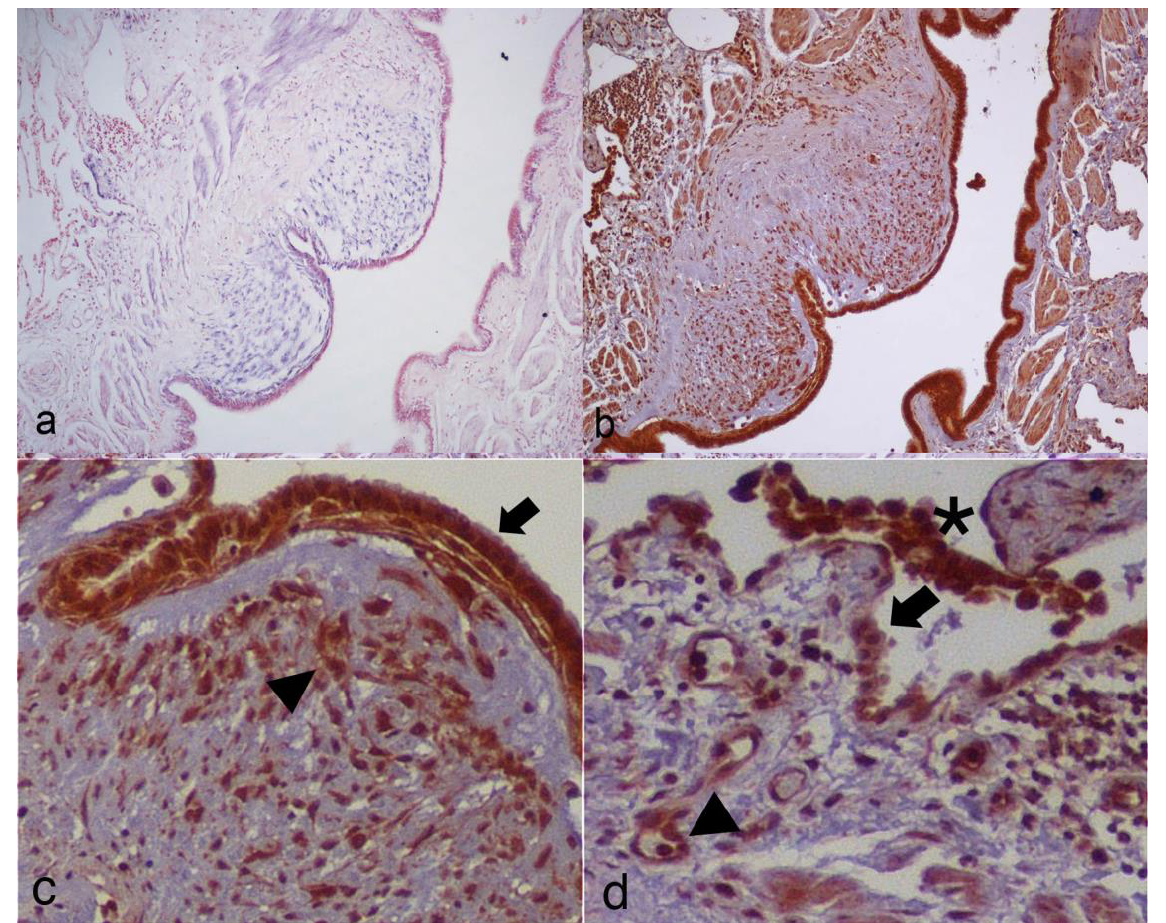
Figure 4. Tissue localization of miR-21-5p and STAT3 in OB lesions. Photomicrographs representative of the co-localization of miR-21-5p ( a ) and STAT3 ( b ) in fibroblast of OB lesions and in the adjacent tissue. High magnification pictures show details of STAT3 expression in ( c ) bronchial epithelium (arrow) and OB fibroblast (arrowhead), and in ( d ) alveolar pneumocytes (arrow), endothelia (arrowhead), and macrophages (asterisk).